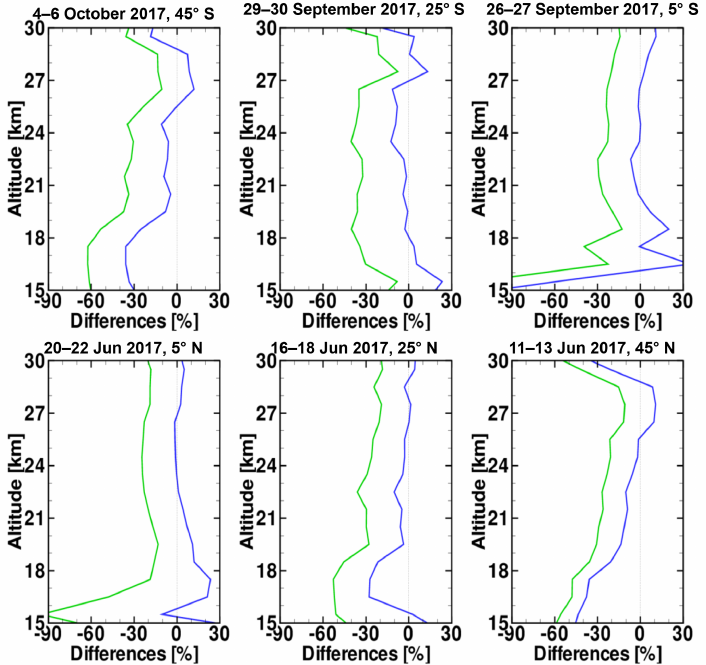
Figure 12. Relative differences of the mean aerosol extinction profiles between 675nm OMPS/LP and 676nm SAGE III/ISS. Difference = 200 × ( LP − SAGE )/( LP + SAGE ) . Blue lines: LP V1.5–SAGE; green lines: LP V1.0–SAGE.